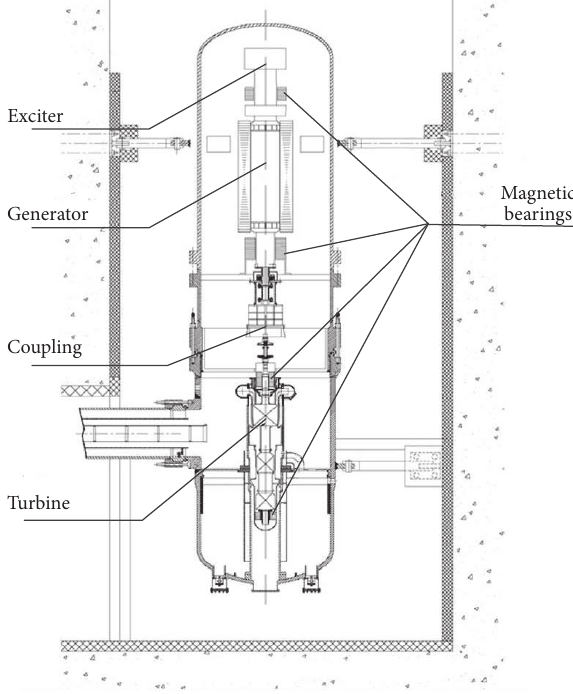
Figure 1: The layout of PCU in